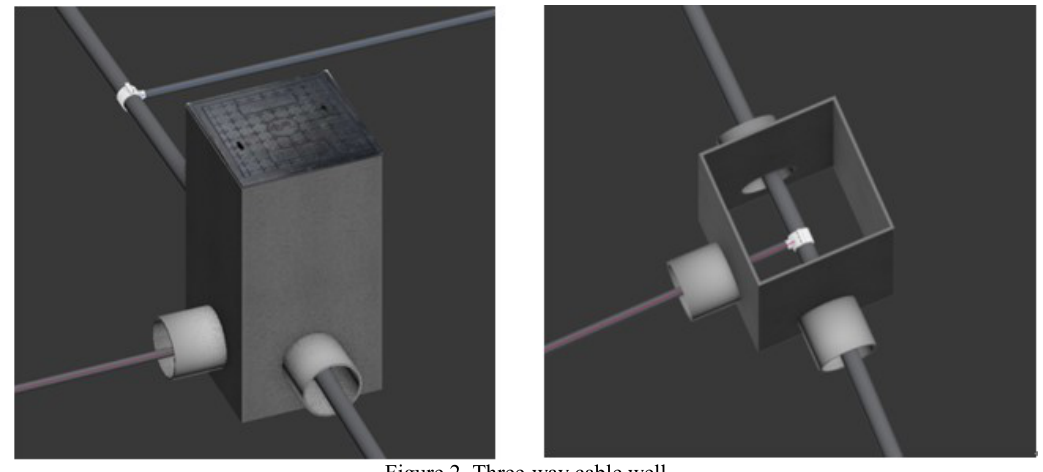
Figure 2. Three-way cable